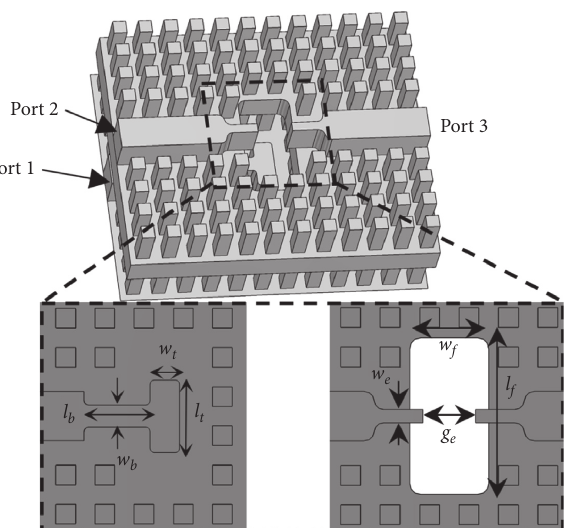
Figure 10: The structure of the E -probe transition between feed-1 and feed-2 layers ( l f � 7 mm, w f � 3.45mm, w e � 0.6mm, g